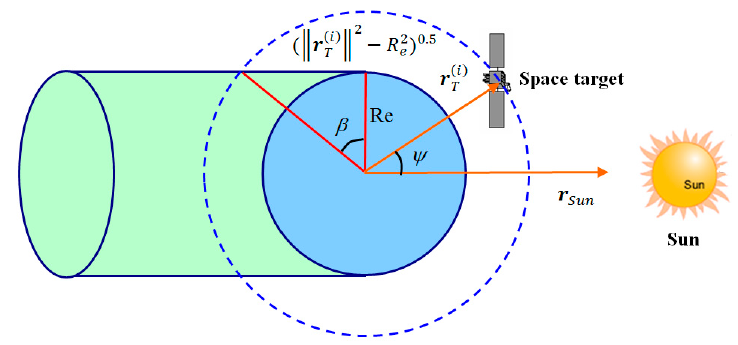
Figure 4. Earth’s shadow in the orbit of space target.